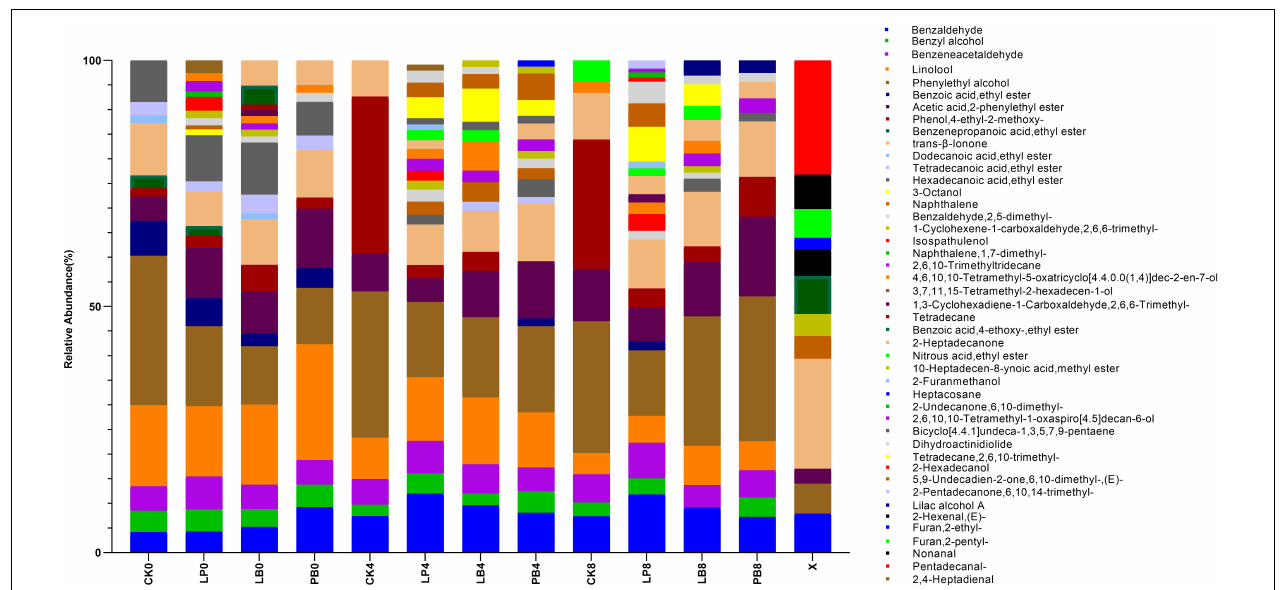
FIGURE 3 | Changes in the abundance of volatile chemicals during aerobic exposure of silage. CK, no additive control; LP, Lactobacillus plantarum ; LB, Lactobacillus buchneri ; PB, Lactobacillus plantarum + Lactobacillus buchneri ; X, fresh sample.